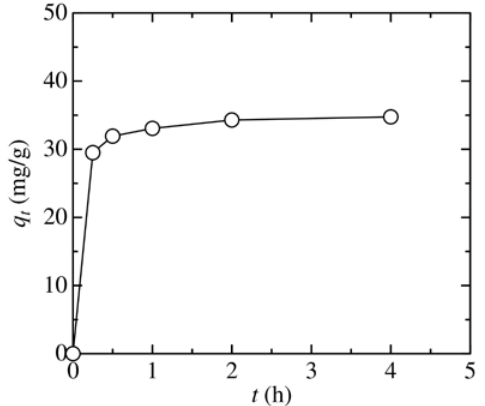
Figure 11. MO adsorption of the DA5 sample as a function of contact time (dosage = 0.5 g/L, initial concentration = 20 mg/L, initial pH = 6.9, temperature = 301 K).